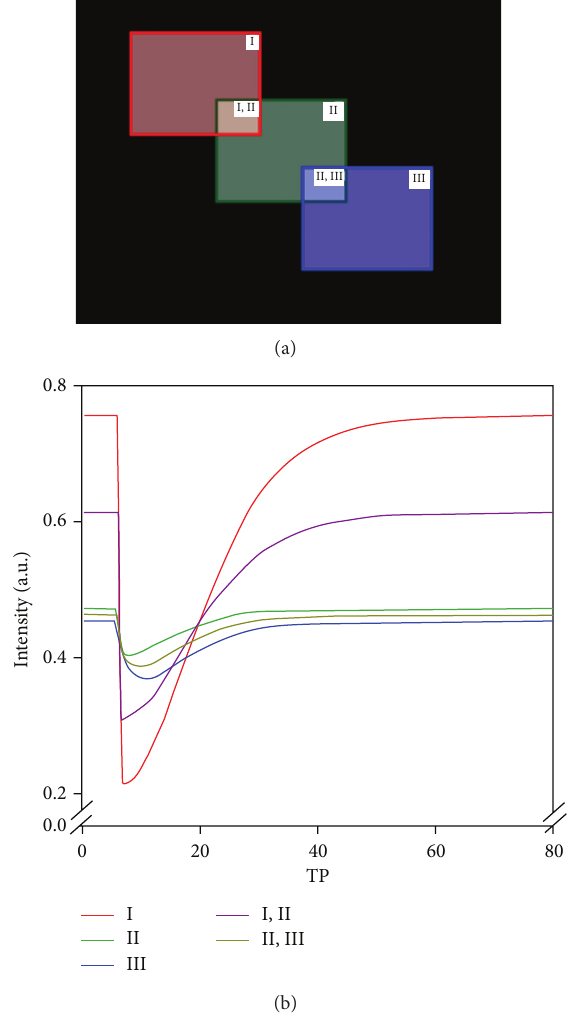
Figure 1: (a) The physiological signals for artery (I), surrounding tissue (II), and tissue (III) are simulated in three blocks (in red, green, and blue, resp.). The partial volume fractions between (I, II) and (II, III) were 0.5. (b) The generated raw signals were calculated from Kiselev’s approach